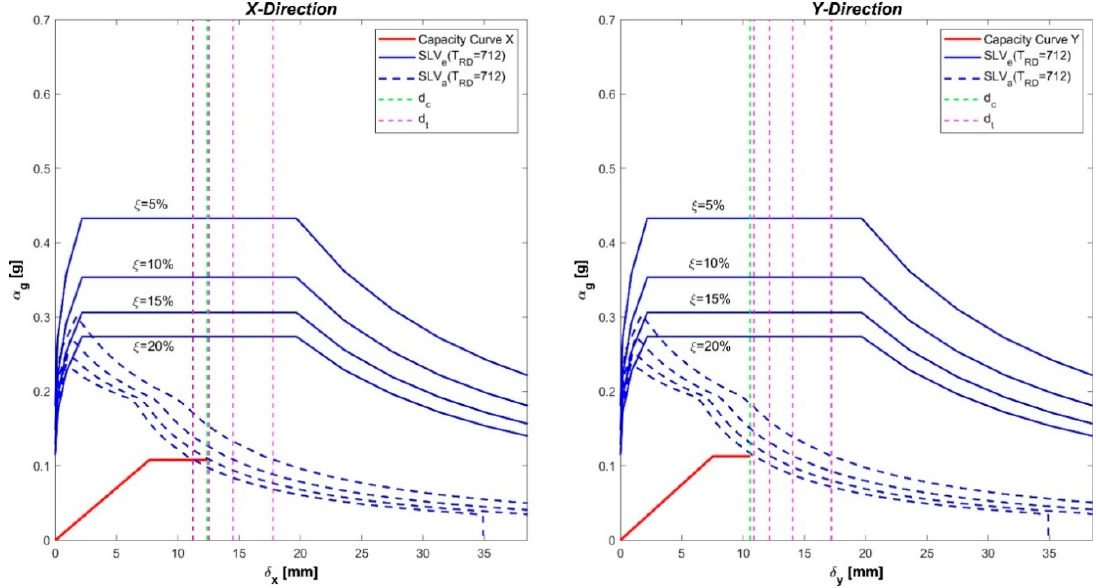
Figure 2. Verification in the ADRS plane parameterized as a function of the damping coe ffi cient ξ .